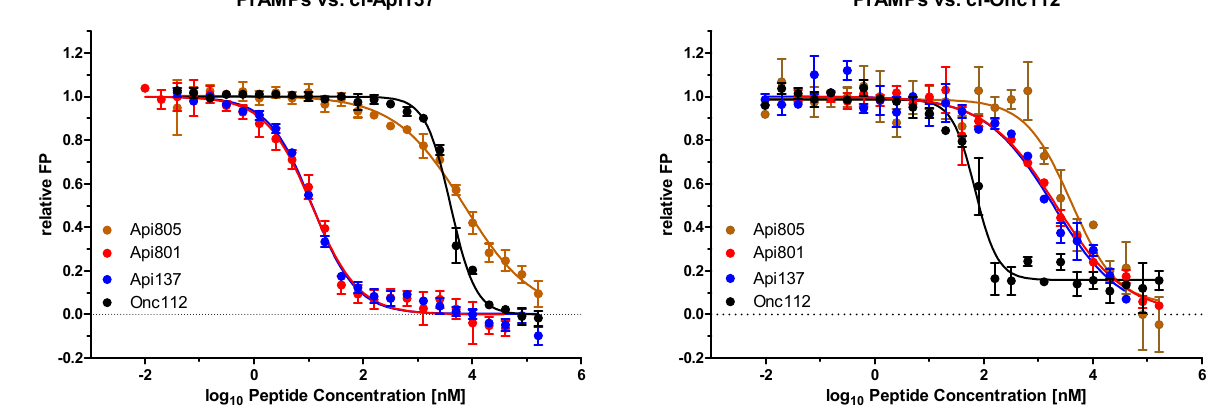
Figure 1. Fluorescence polarization assay testing of Api805 (orange), Api801 (red), Api137 (blue), and Onc112 (black) in competition with cf-Api137 (left) and cf-Onc112 (right) for the ribosomal binding sites of Api137 and Onc112. Experiments were performed twice in triplicate. Error bars indicate the standard deviation of all six replicates. The horizontal dotted line separates positive and negative ranges on the Y-axis.